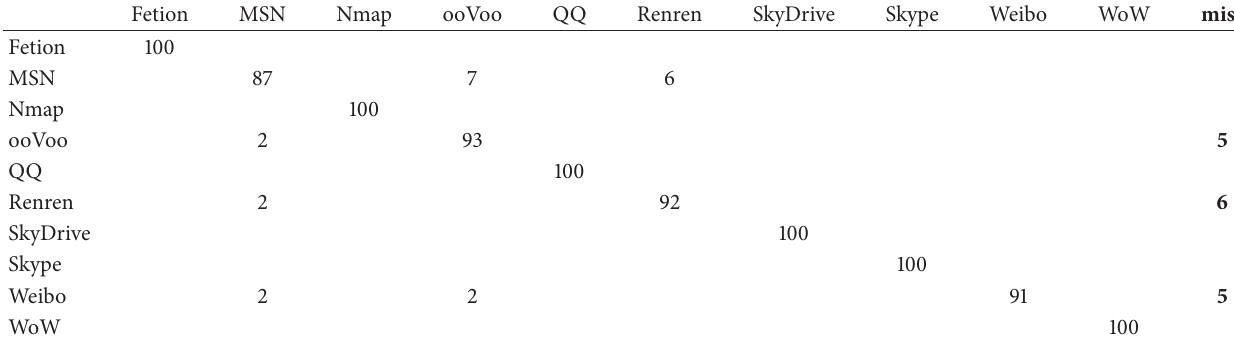
Table 8: Experimental results from network application